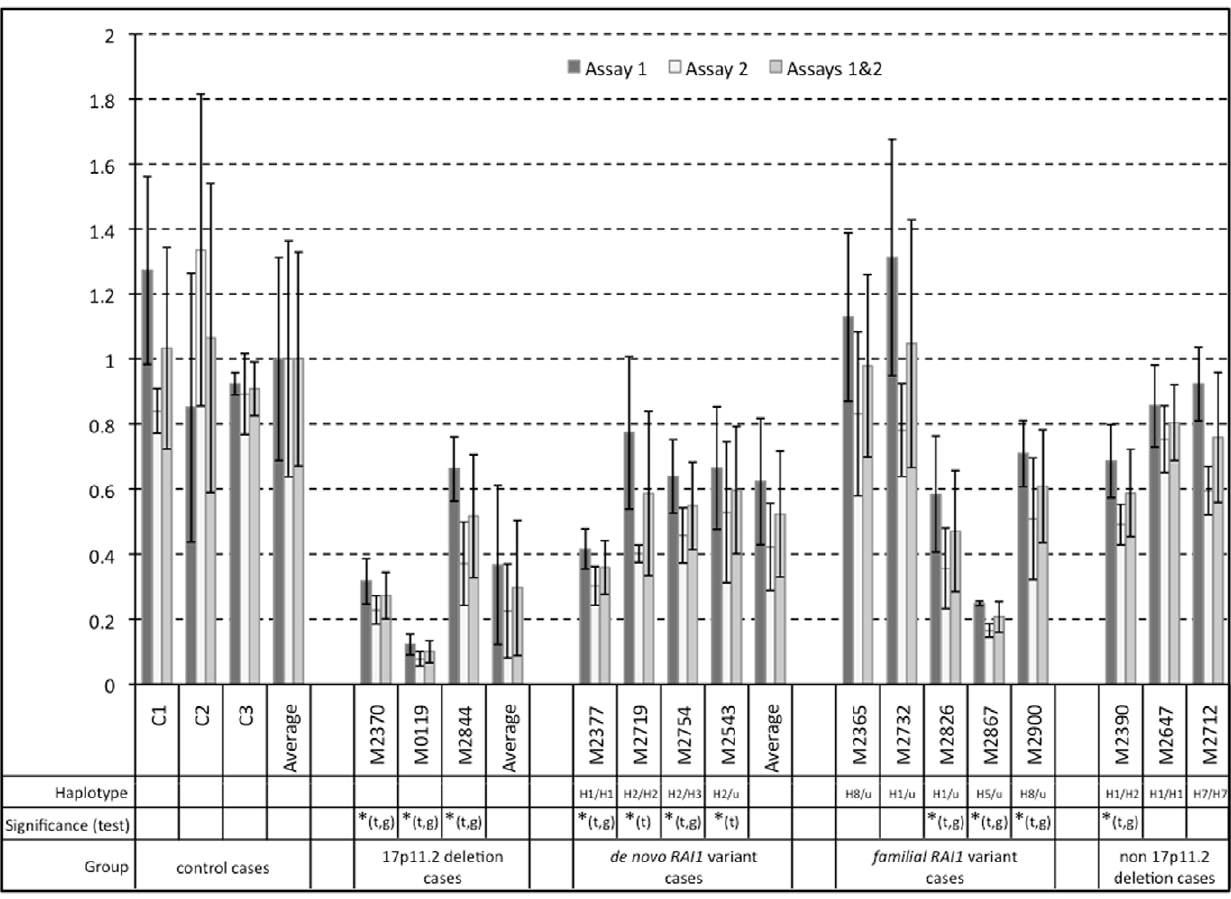
Figure 3. RAI1 mRNA expression in lymphoblastoid cells. RNA extracted from lymphoblastoid cells from SMS patients in 4 subgroups: cases with common 17p11.2 deletion, de novo RAI1 variants (including the ‘unclassified’ variant M2543), familial RAI1 variants, and non-17p11.2 deleted without identified RAI1 variants, as well as from 3 control cell lines were used for RAI1 mRNA expression analysis by qPCR. Two Taqman primer-probe assays were used per sample (assay 1 and assay 2). Displayed values represent the relative quantification (RQ) compared to the average of all control assays (set to 1). *: Average RQ of the sample is statistically different (p , 0.05) from the average of all control cases (t: using the ANOVA post hoc Tukey-Kramer test; g: using the ANOVA post hoc Games-Howell